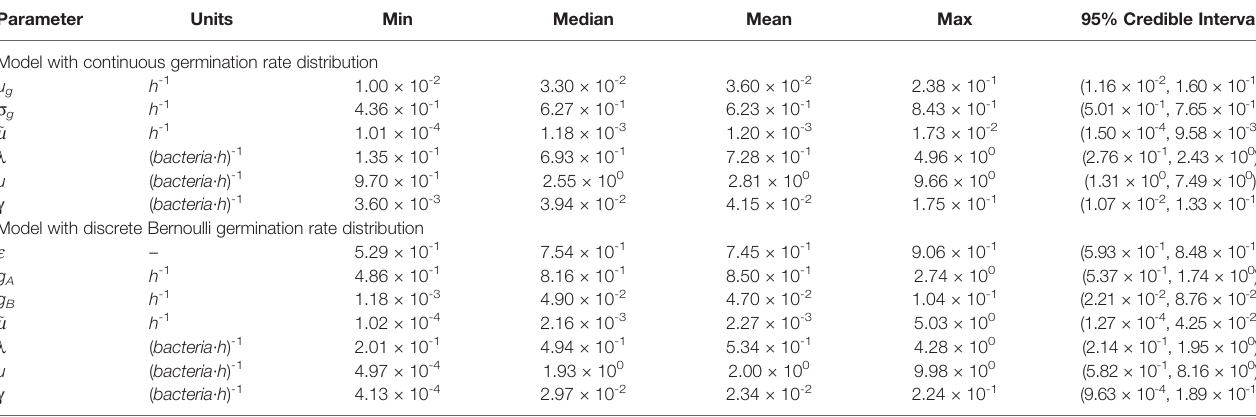
TABLE 4 | Summary statistics for the posterior sample of each parameter, shown in blue in Figure 3 , for the model with continuous heterogeneity of germination rate (top) and two types of spores (bottom). Parameter Units Min Median Mean